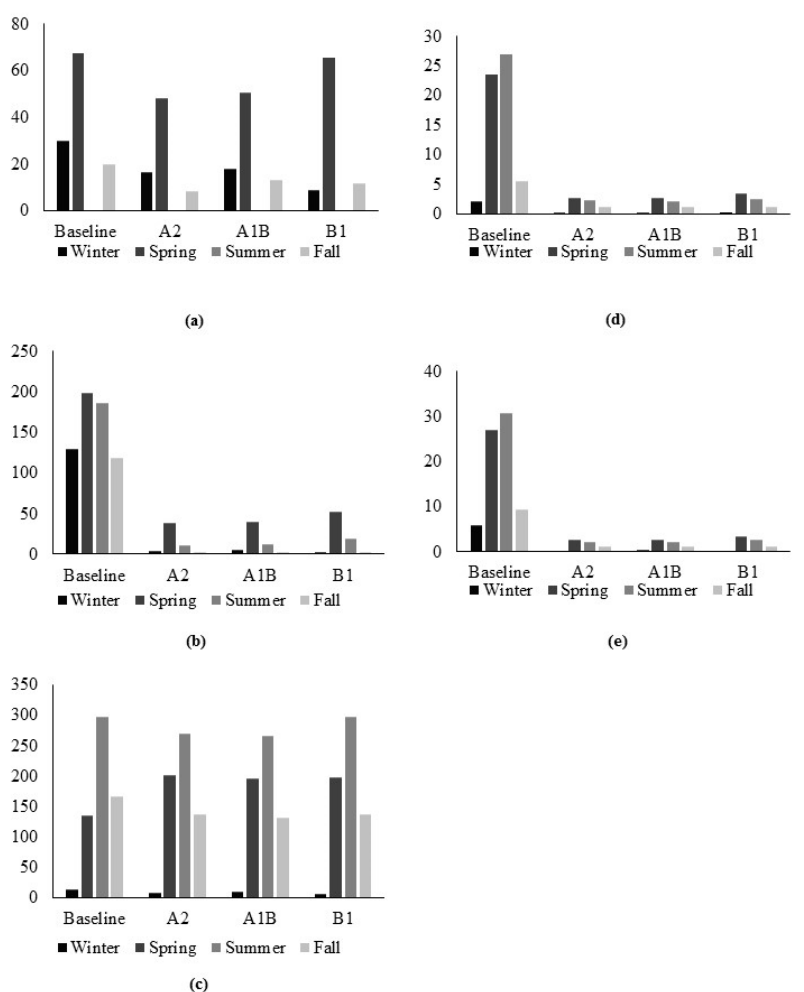
Figure 4. Variations in different hydrologic components ( a ) Snowmelt, in mm; ( b ) Soil water storage (SW), in mm; ( c ) Actual evapotranspiration (AET), in mm; ( d ) Surface runoff (SURQ), in mm; € Total water yield (WYLD), in mm on seasonal basis in response to projected climate change scenarios